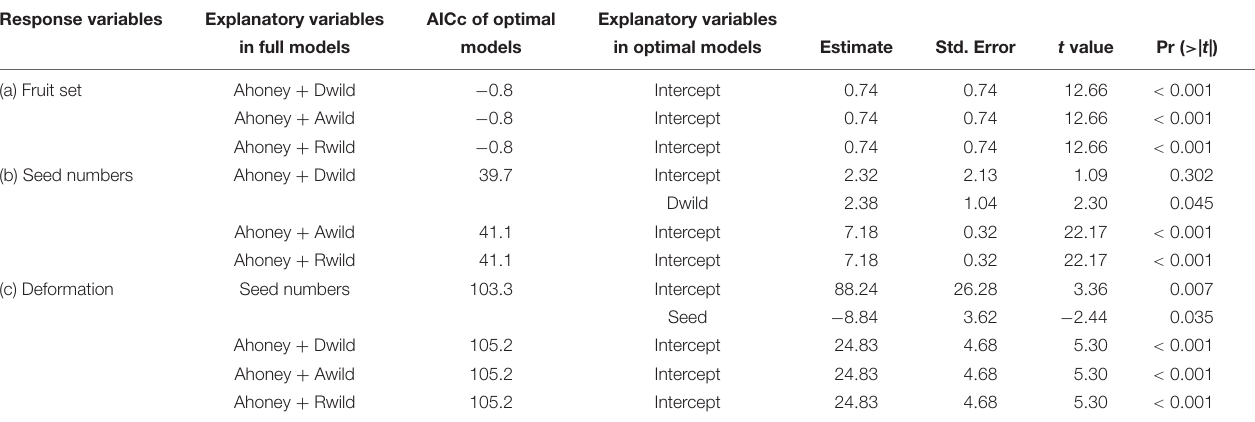
TABLE 1 | Results from linear models (lm) indicating the effects of bees on apple fruit set (a), seed numbers (b), and deformation (c), and the effect of seed numbers on deformation (c). Response